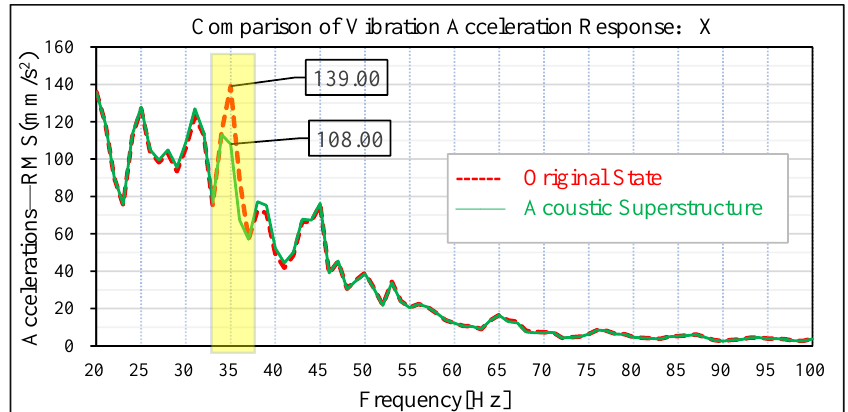
Figure 20. Comparison of sound pressure levels in the middle of rear passenger row.